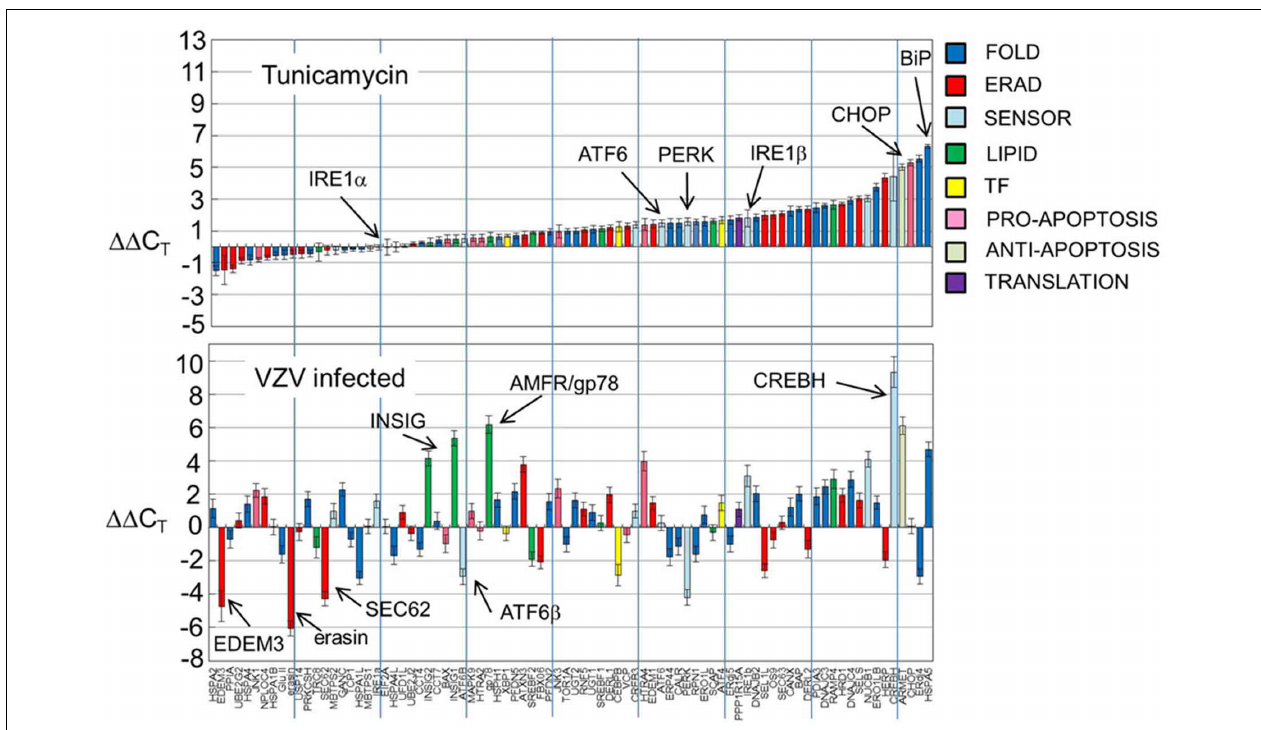
normalized ( (cid:2) C T ) by the housekeeping genes of the plate and differences ( (cid:2)(cid:2) C T ) between the uninfected and infected or tunicamycin treated values were computed and averaged. Graphs of the resulting values show that tunicamycin treatment, a classical ER stressor, resulted in upregulation of 66 of the 84 UPR genes with known folding chaperones such as BiP (in blue). Also upregulated was the pro-apoptotic factor CHOP . By contrast, only 43 of the UPR genes were upregulated in VZV infected cells although several, such as CREBH , were more upregulated than in tunicamycin treated samples. Error bars correspond to standard deviation when